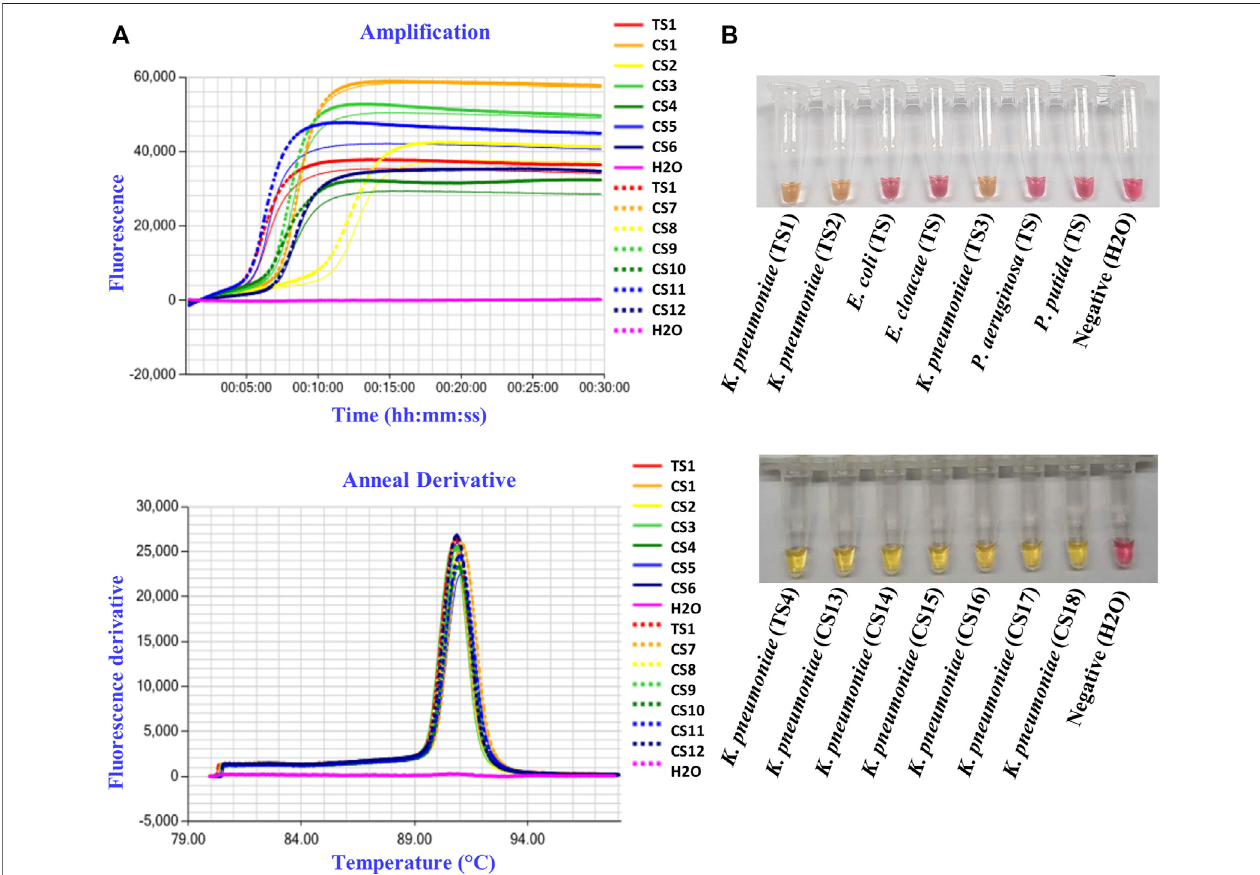
FIGURE2| K.pneumoniae LAMPdetectioninpurecultures. (A) Representative fl uorometricLAMPresults,targetingthe yhaI gene,performedontypestrain(TS1) and clinical isolates (CS1 – 12) of K. pneumoniae from the United Kingdom, with H 2 O as a negative control. (B) Representative colorimetric LAMP results, targeting the yhaI gene,performedontypestrains(TS)andclinicalisolates(CS)of K.pneumoniae fromtheUnitedKingdom(TS1 – 3)andfromChina(TS4andCS13 – 18),aswellason type strains of E. coli , E. cloacae , Pseudomonas aeruginosa , and P. putida , with H 2 O as a negative control.